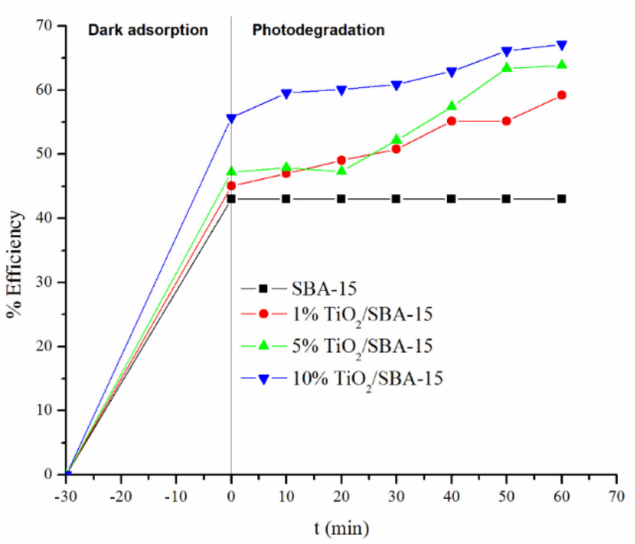
Figure 6. Photodegradation of methylene blue over SBA-15 before and after titania impregnation. Table 2. Efficiency of methylene blue removal by 1, 5, 10 wt% TiO 2 /SBA-15 photocatalyst at 90 min of contact time. The result compares with SBA-15 and reported